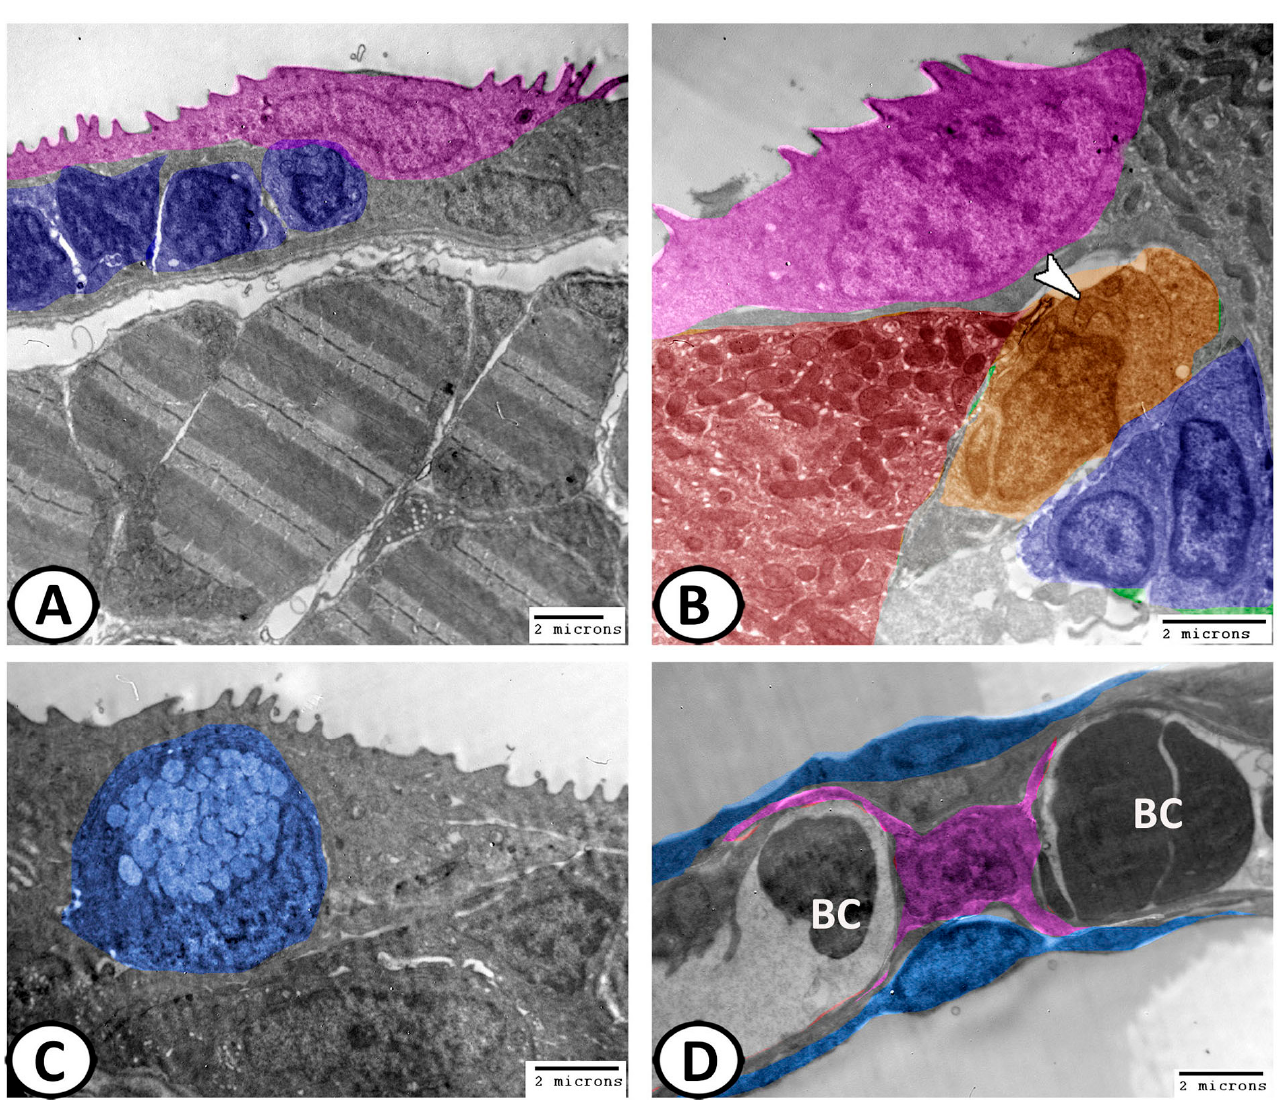
Figure 9. Digital colored TEM images of gills. ( A , B ) Apical PVC with microridges (pink) with many underlining lymphocytes (blue), chloride cells (red), and stem cells (orange) with dividing nucleus and cytoplasm contained mitochondria (arrowhead). ( C ) Mucous cells (blue) with apical mucous droplets are seen on the surface of gill filaments. ( D ) lamellar blood channel showing blood capillaries (BC), pillar cells (pink), and squamous PVC (blue). 3.3.5. Other Cells Other cells found within the filament interstitium include lymphocytes, macrophages, monocytes, neuroepithelial cells, telocytes, and stem cells. The lymphocytes were characterized by a high nucleus to cytoplasmic ratio and distributed in the epithelium of the primary gill lamellae (Figures 8A,B and 9A,B) and the interstitial connective tissues around the blood vessels (Figure